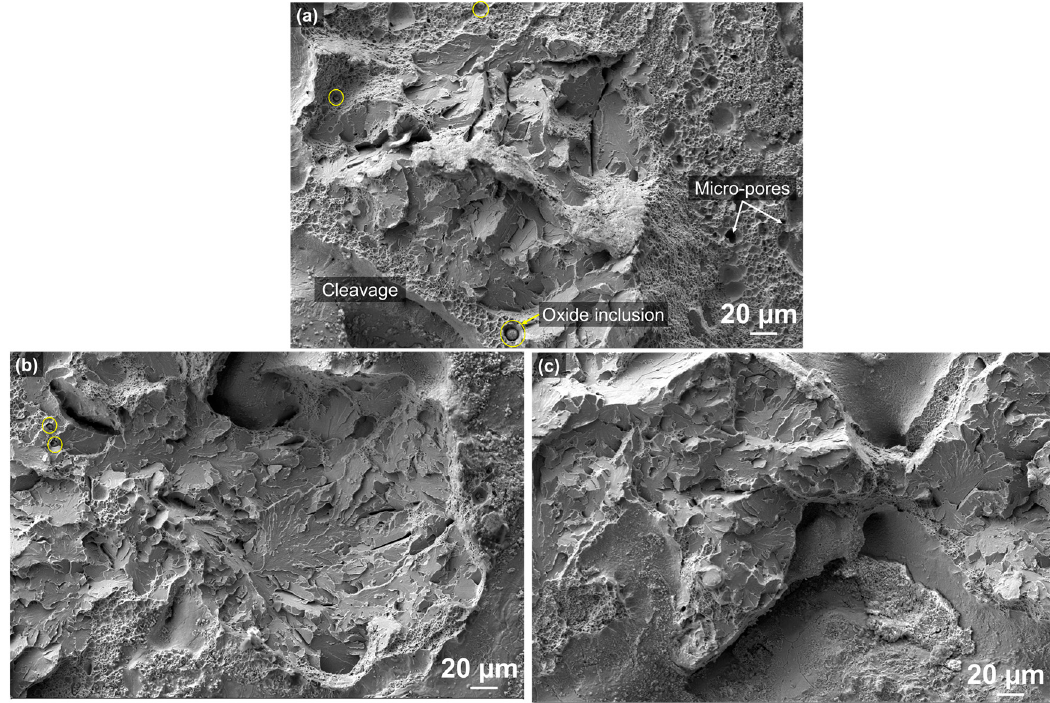
Figure 5. ( a – c ) High magnification views of the fracture surface after tensile testing showing a transgranular quasi-cleavage fracture mode.